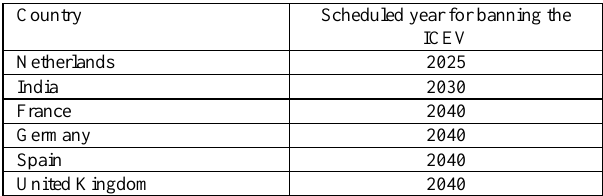
Table 2. Planned restrictions on the possibility of registering new cars